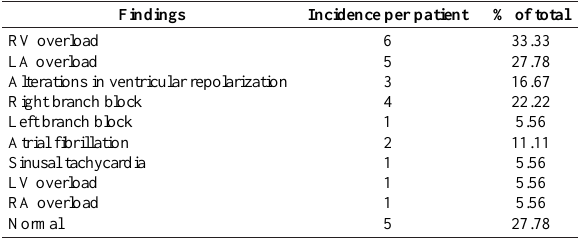
LA- left atrium, LV- left ventricle, RA- right atrium, RV- right ventricle.